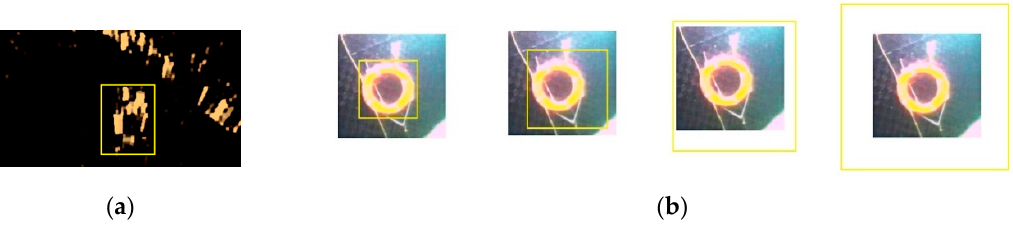
Figure 4. The process of multiscale matching. In subfigure ( a ), we select the target object in the acoustic image, and subfigure ( b ) shows its matching process in each layer of Gaussian scale-space.